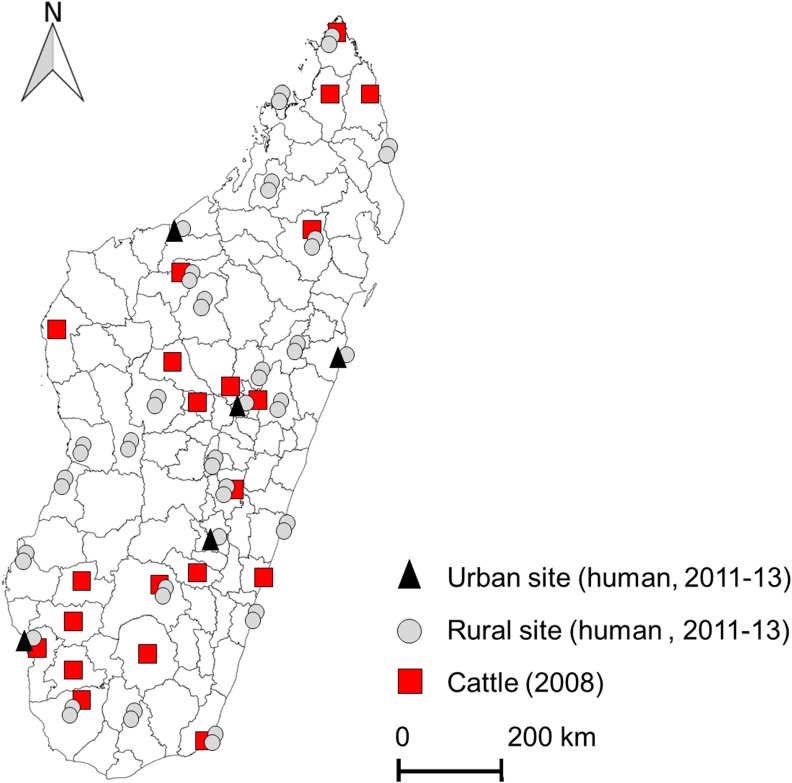
Cattle and human sampling sites [17].Animal and human sera were analyzed using commercial ELISA kits (Biological Diagnostic Supplies Ltd., BDSL) to detect anti-RVFV immunoglobulin (Ig) G [17,22,23]. Cattle and human data were aggregated at the commune level (n = 1,578).